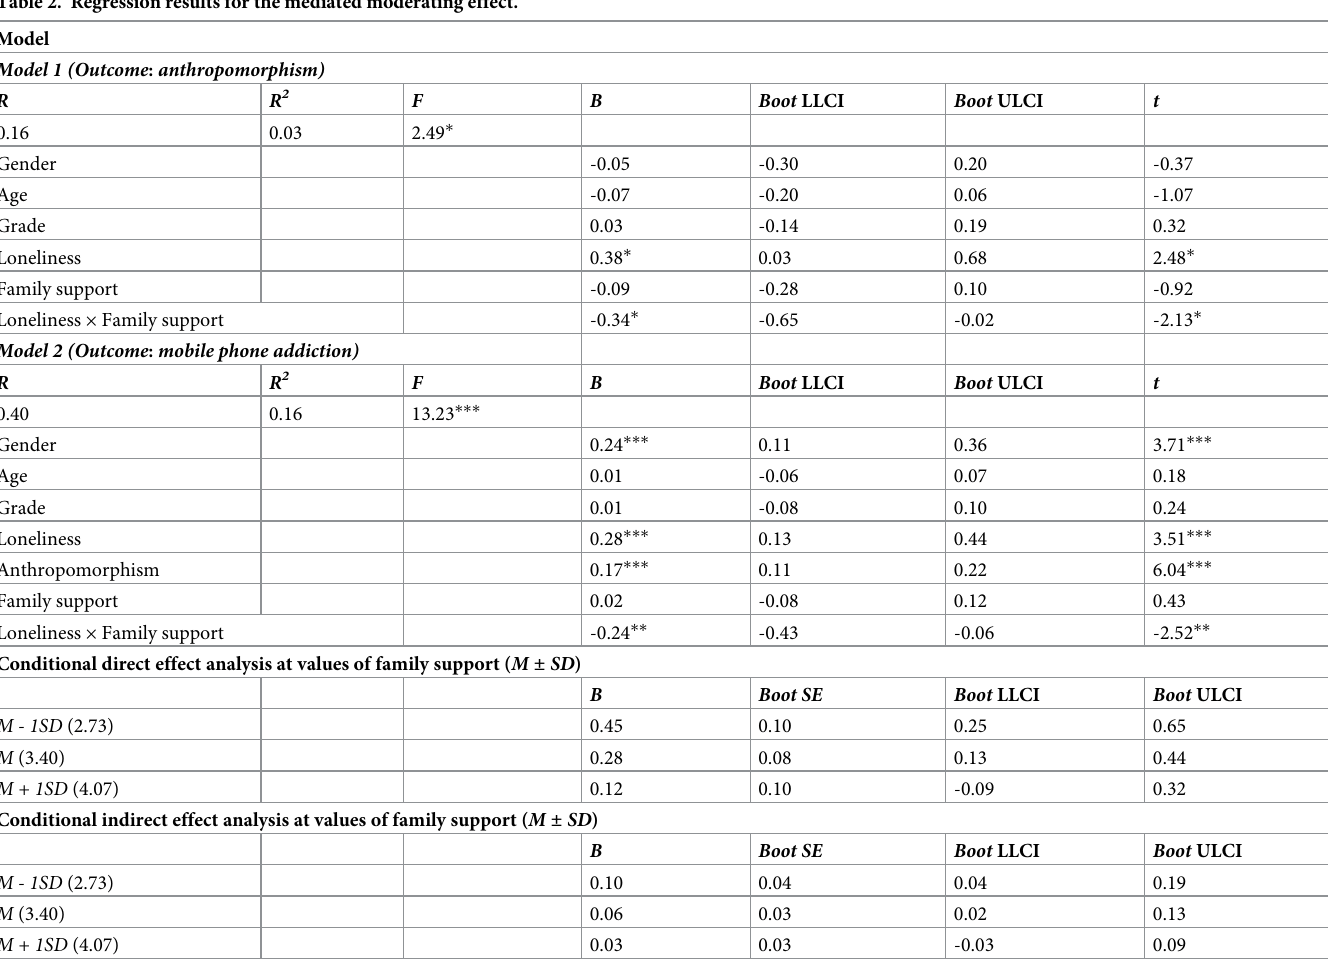
Table 2. Regression results for the mediated moderating